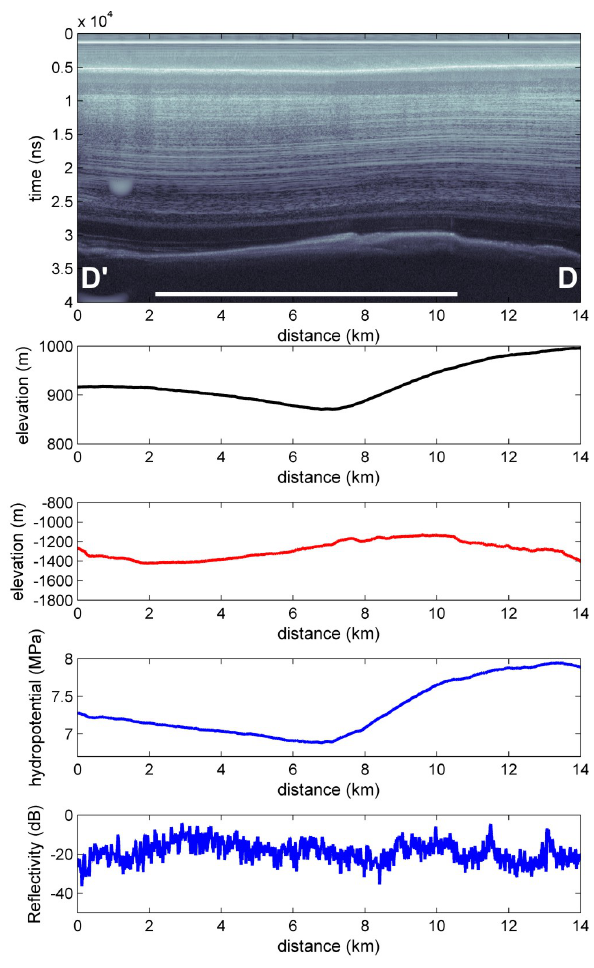
Fig. 8. RES transect D–D’ (see Fig. 1b for location), along the ap- proximate line of ice flow (from D to D’). The coverage of the ICESat-derived lake extent (after Smith et al., 2009) is shown as a white line on the radargram. Beneath the radargram graphs of ice surface elevation (black line), bed elevation (red line), basal hy- dropotential (upper blue line) and basal reflectivity (lower blue line) are